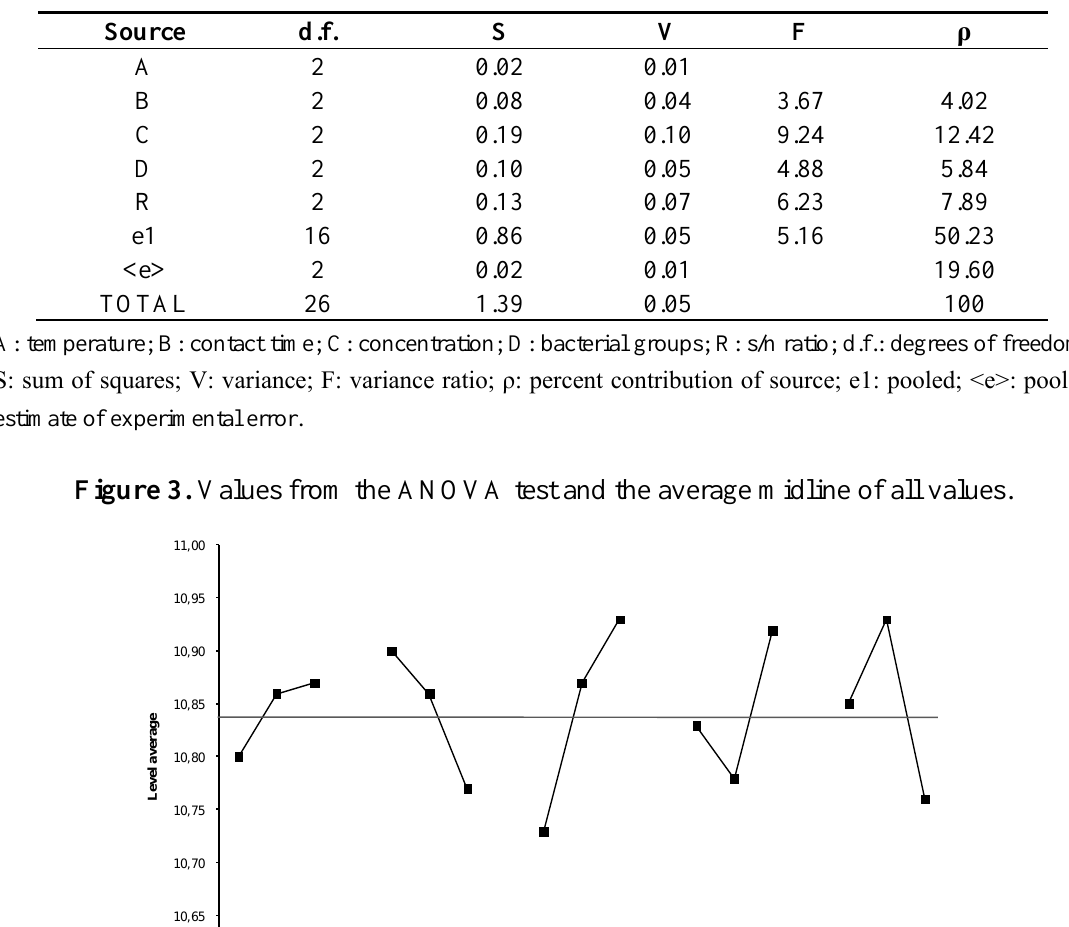
Table 5. Values from the ANOVA test.